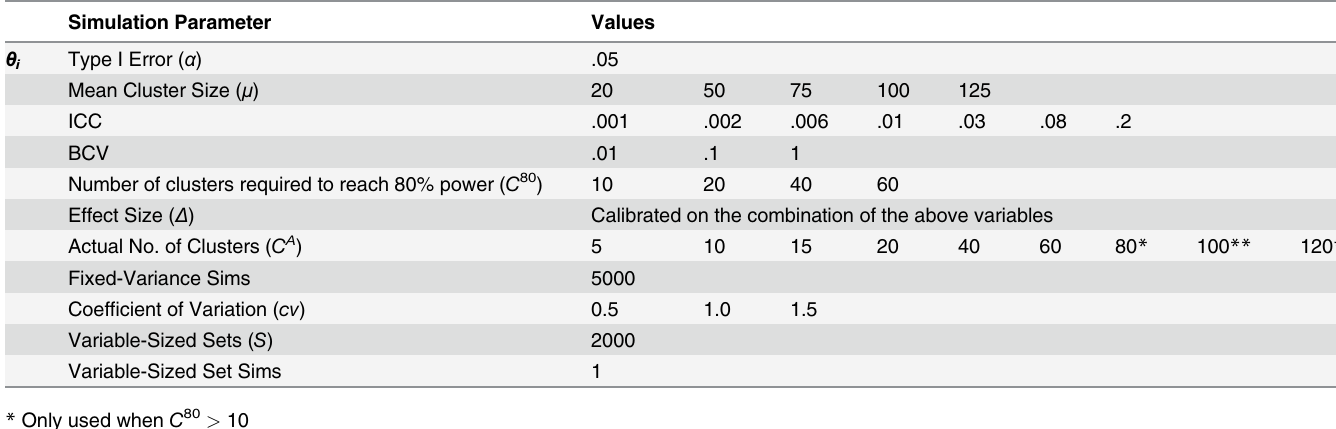
Table 1. List of simulation parameters and their